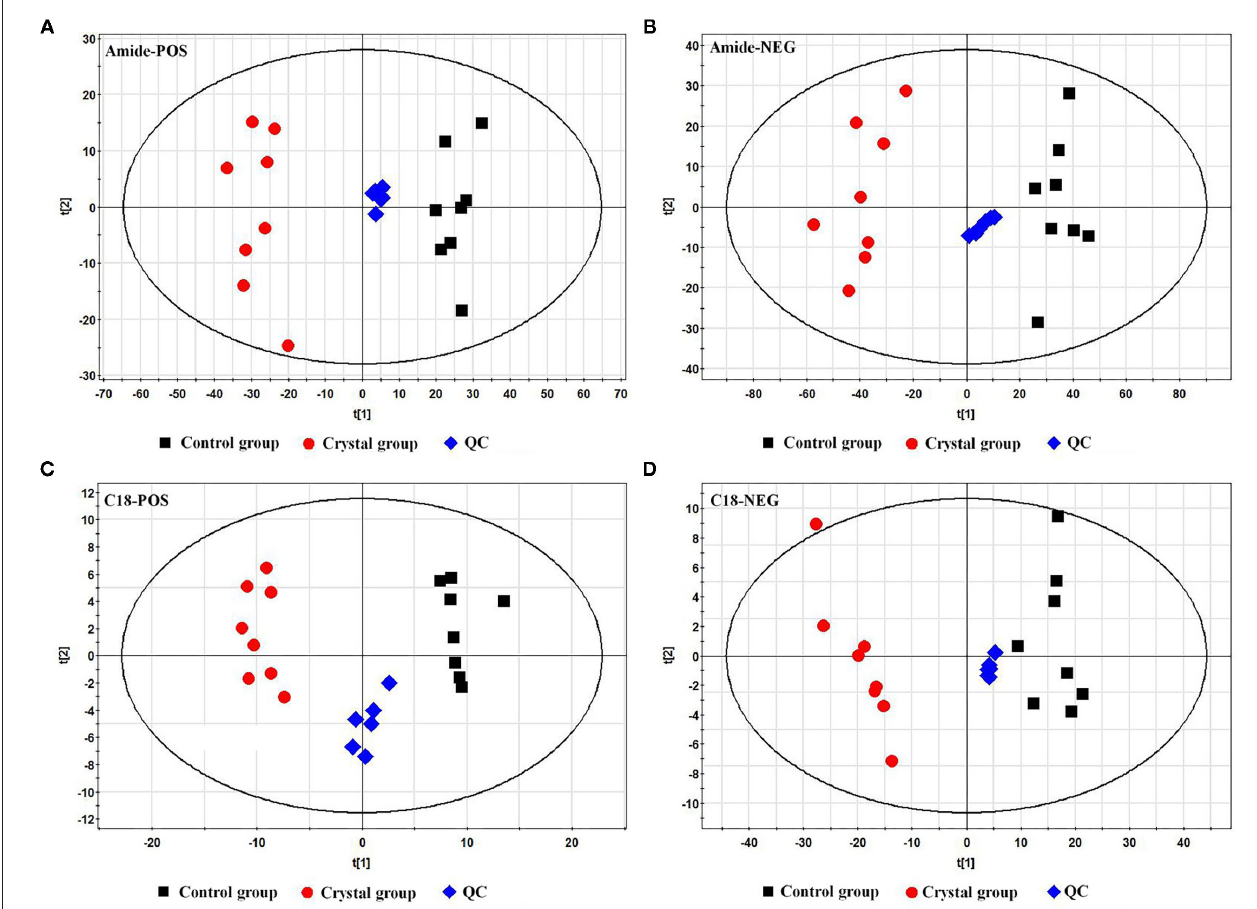
FIGURE 2 | Principal component analysis (PCA) score plots of the Control group, Crystal group, and QC samples based on metabolites. (A) A plot in the ESI + mode using an amide column, (B) a plot in the ESI − mode using an amide column, (C) a plot in the ESI + mode using a C18 column, and (D) a plot in the ESI − mode using a C18